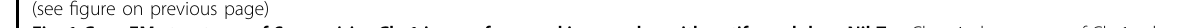
Fig. 1 Cryo-EM structures of S. cerevisiae Chs1 in apo-form and in complex with antifungal drug NikZ. a Chemical structures of Chs1 substrate UDP-GlcNAc and antifungal drug NikZ. b Activity assay of Chs1. c The reactants under different reaction conditions and times (6 h, 16 h) were stained by calco fl uor white to visualize chitin formed. Commercial chitin was included as a positive control. d Inhibition pro fi le of Chs1 activities by NikZ. e Cryo-EM map of Chs1 complexed with NikZ. Two protomers are colored in green and blue, respectively, and lipid densities in yellow. f Dimeric overall structure of Chs1/NikZ complex. Lipids are shown as yellow sticks and NikZ as red spheres. g Cartoon representation of one Chs1 protomer with bound NikZ (as yellow sphere). Inset, NikZ (as yellow stick) superimposed with its corresponding density (as blue mesh). h Coordination of NikZ in Chs1 active site. NikZ-interacting residues are shown as magenta sticks. Black dashed lines indicate polar interactions. E716 and D717 (cyan sticks) from the conserved ‘ ED motif ’ , are close to but not contacting NikZ. i In vitro activities of Chs1 active site mutants with or without NikZ. j The reactants (reaction time: 16 h) in the presence of Chs1 active site mutants were stained by calco fl uor white to visualized chitin formed. k The transmembrane domain encloses a membrane tunnel for chitin translocation. A lipid-like density (yellow mesh) resides within the membrane tunnel. The arrow indicates a possible exit for translocation. The asterisk indicates a membrane-wrapped lateral opening to the membrane tunnel. l Structural comparison of their active sites between the Chs1/NikZ complex and apo-Chs1. A ‘ plug loop ’ (in cartoon with two residing residues P675 and A677 shown in sticks) exhibits altered conformations to block (apo-state) or open (NikZ-bound state) the path connecting the active site and the membrane tunnel. m Conformational changes in Chs1 active site upon NikZ binding. The red arrows indicate the altered conformations of ‘ plug loop ’ and I631 on IF1 before and after drug binding. All assays were performed in triplicates. The error bars indicate